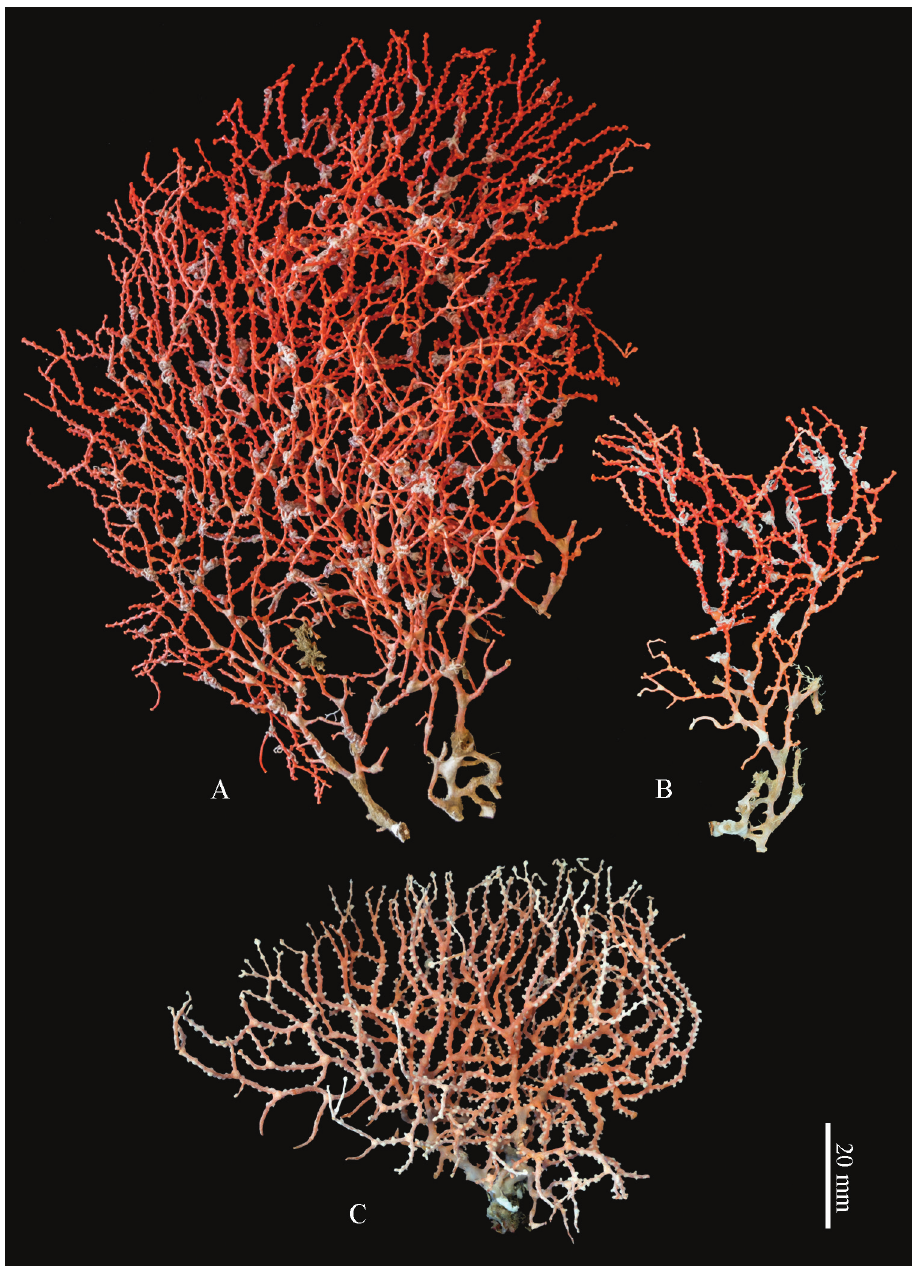
Figure 3. Colonies of Melithaea davidi sp. n.; A holotype, RMNH Coel. 42122 B paratype, RMNH Coel. 42123 C paratype, RMNH Coel.